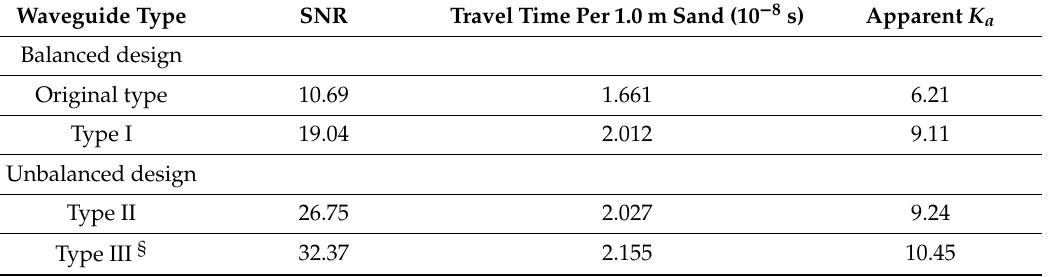
Table 2. The measurement performance evaluation of TDR sensing